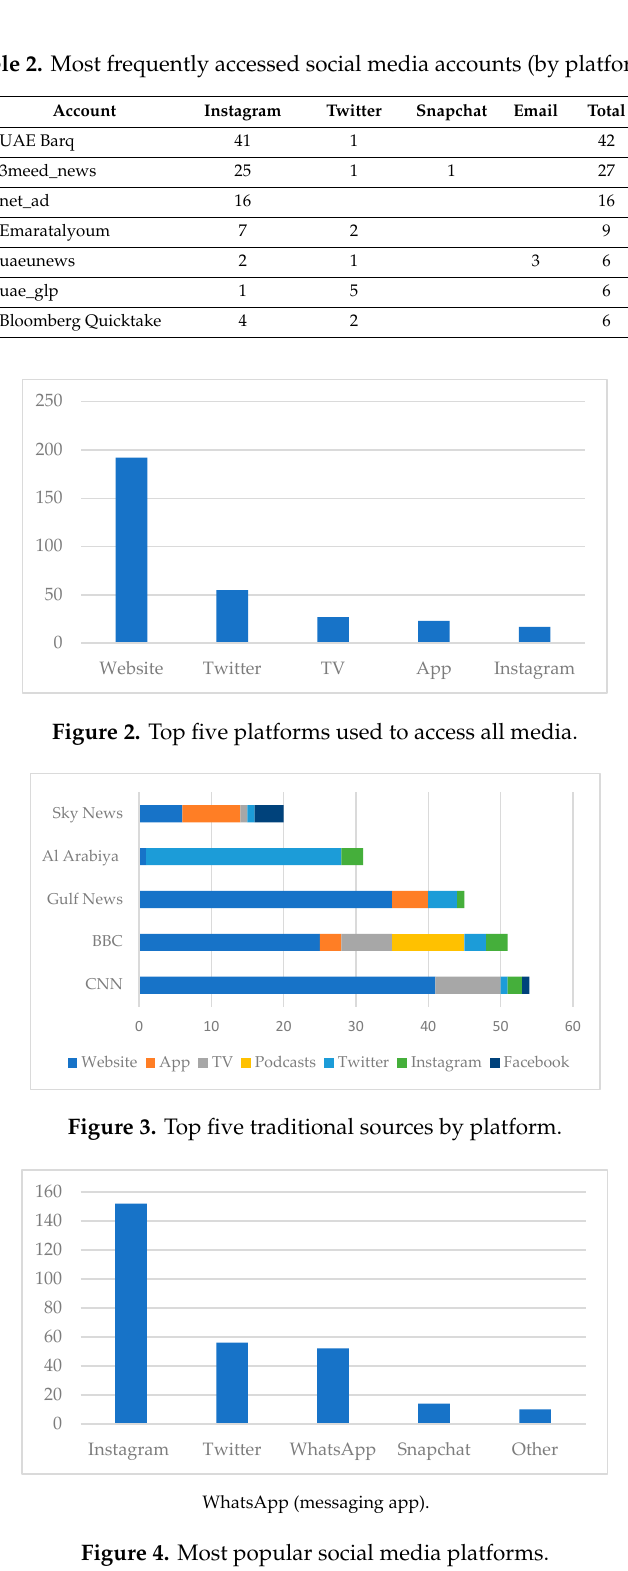
Figure 4. Most popular social media 1 platforms.